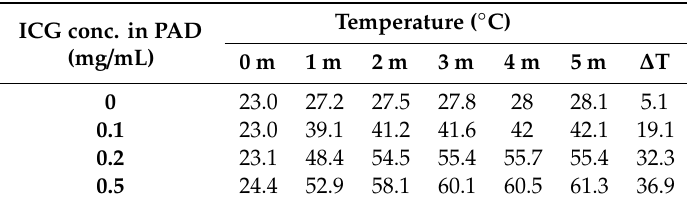
Table 2. Changes in the temperature during 808 nm laser irradiation with a power density of 1 W / cm 2 in PAD-ICG. Temperature ( ◦ C) ICG conc. in PAD (mg / mL) 0 m 1 m 2 m 3